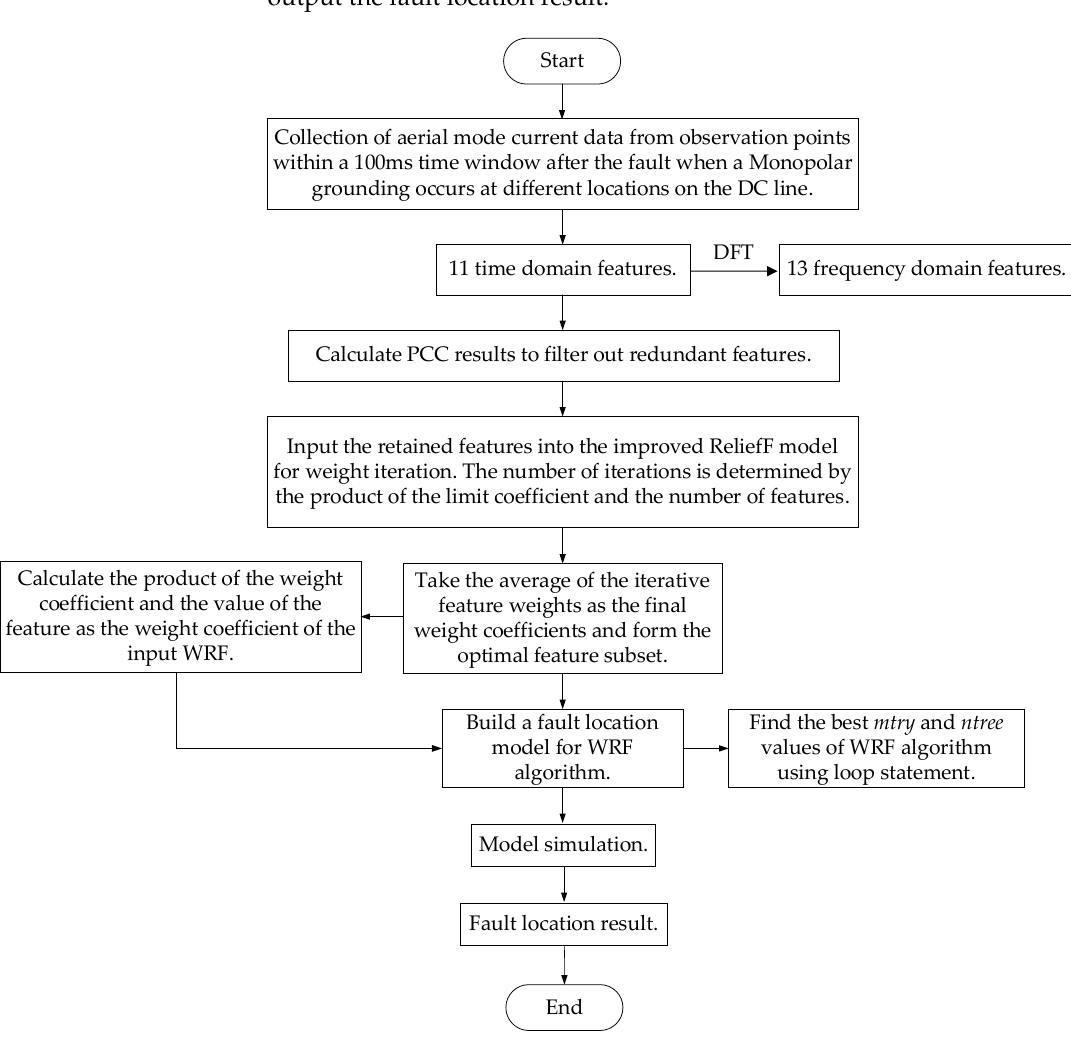
Figure 5. Flowchart of the fault location method.